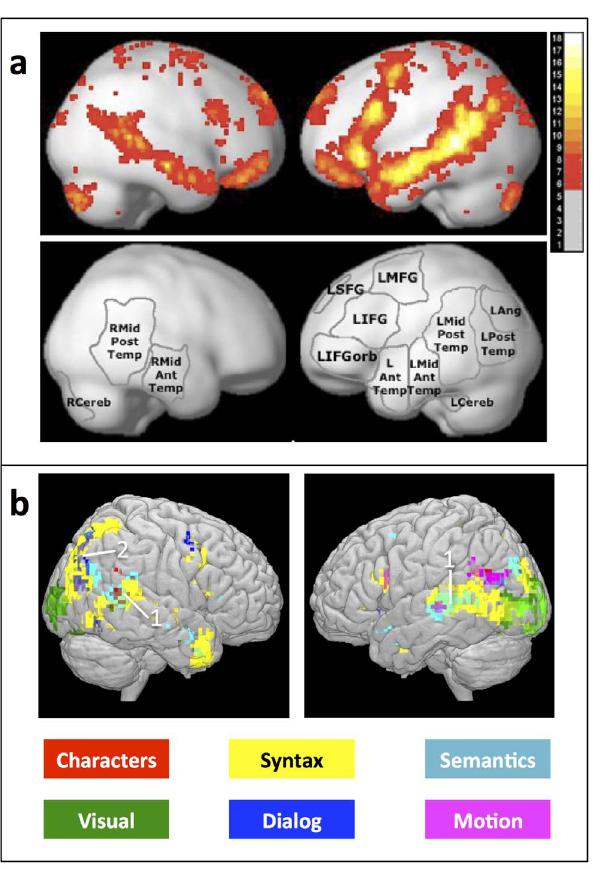
Figure 4. Map of the patterns of representation compared with the regions involved in sentence processing: our method recovers similar regions and differentiates them according to which information process they represent. a - Adapted from [8]: Top: A recently published probabilistic overlap map showing where sentence reading generates greater neural activity than perceiving nonword letter strings. The value in each voxel indicates how many of the 25 individual subjects show a significant (at p v : 05 , FDR- corrected) effect for the Sentences w Nonwords contrast. Bottom: The main functional parcels derived from the probabilistic overlap map using an image parcellation (watershed) algorithm, as described in more detail in [7]. b - Results obtained by our generative model, showing where semantic, discourse, and syntax information is encoded by neural activity. Note this model identifies not just where language processing generates neural activity, but also what types of information are encoded by that activity. Each voxel location represents the classification done using a cube of 5 | 5 | 5 voxel coordinates, centered at that location, such that the union of voxels from all subjects whose coordinates are in that cube are used. Voxel locations are colored according to the feature set that can be used to yield significantly higher than chance accuracy. Light green regions, marked with (1), are regions in which using either semantic or syntactic features leads to high accuracy. Dark gray regions, marked with (2), are regions in which using either dialog or syntactic features leads to high